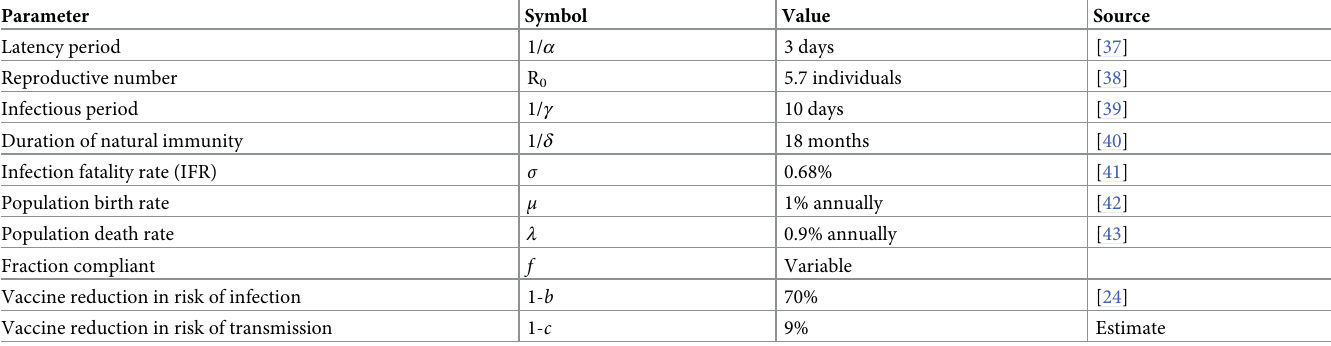
Table 1. Model parameters for SEIRS